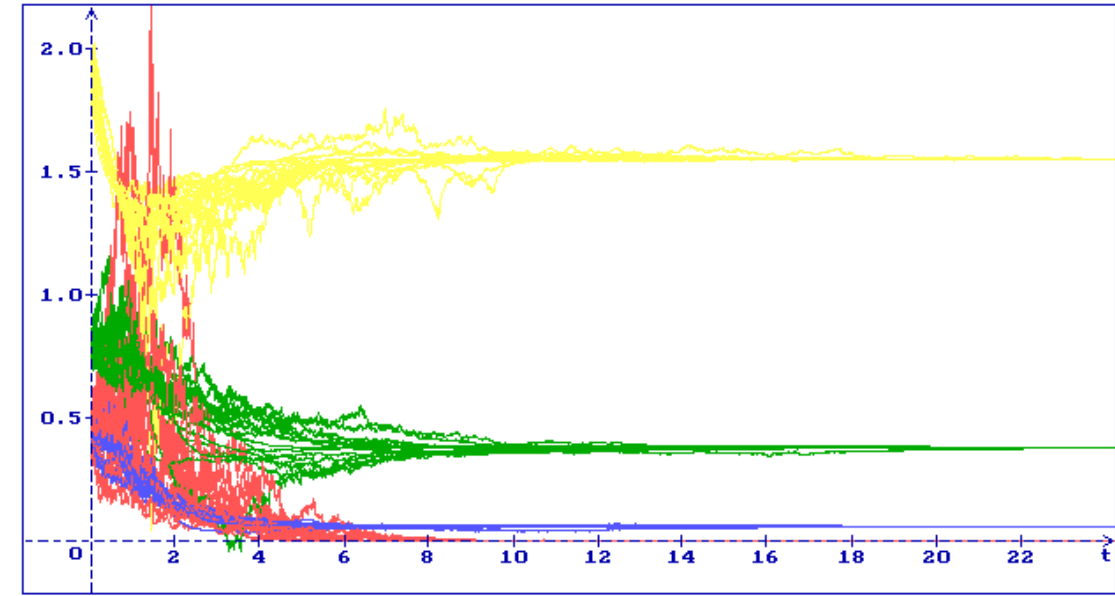
Figure 4. 30 trajectories of the system (6) solution with the initial condition I ( 0 ) = 1.9, S 1 ( 0 ) = 0.8, S 2 ( 0 ) = 0.4, R ( 0 ) = 0.4: all trajectories I ( t ) (yellow), S 1 ( t ) (green), S 2 ( t ) (blue), R ( t ) (red) converge